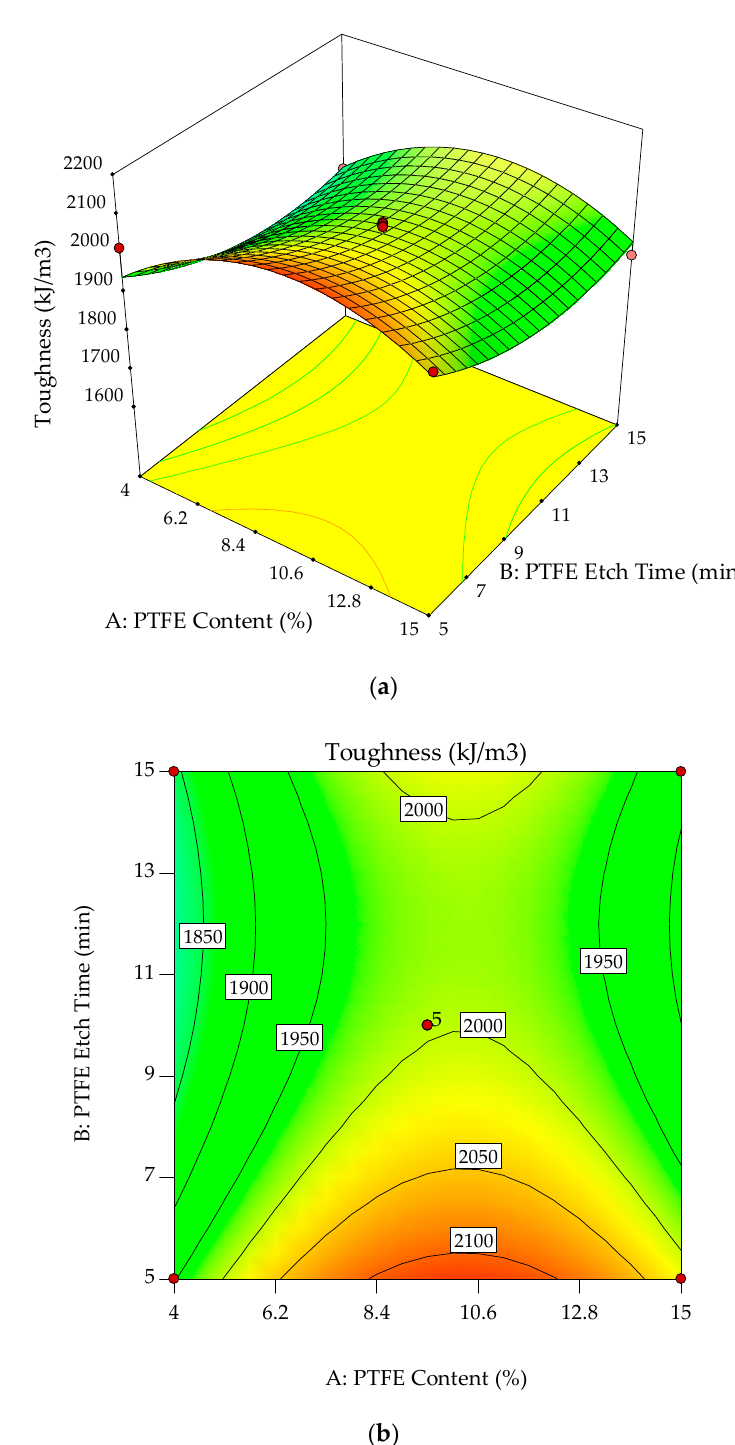
Figure 9. 3D response surface plot ( a ) with 2D contour plot; ( b ) of the effects of PTFE content and PTFE etch time on toughness of POM composites.